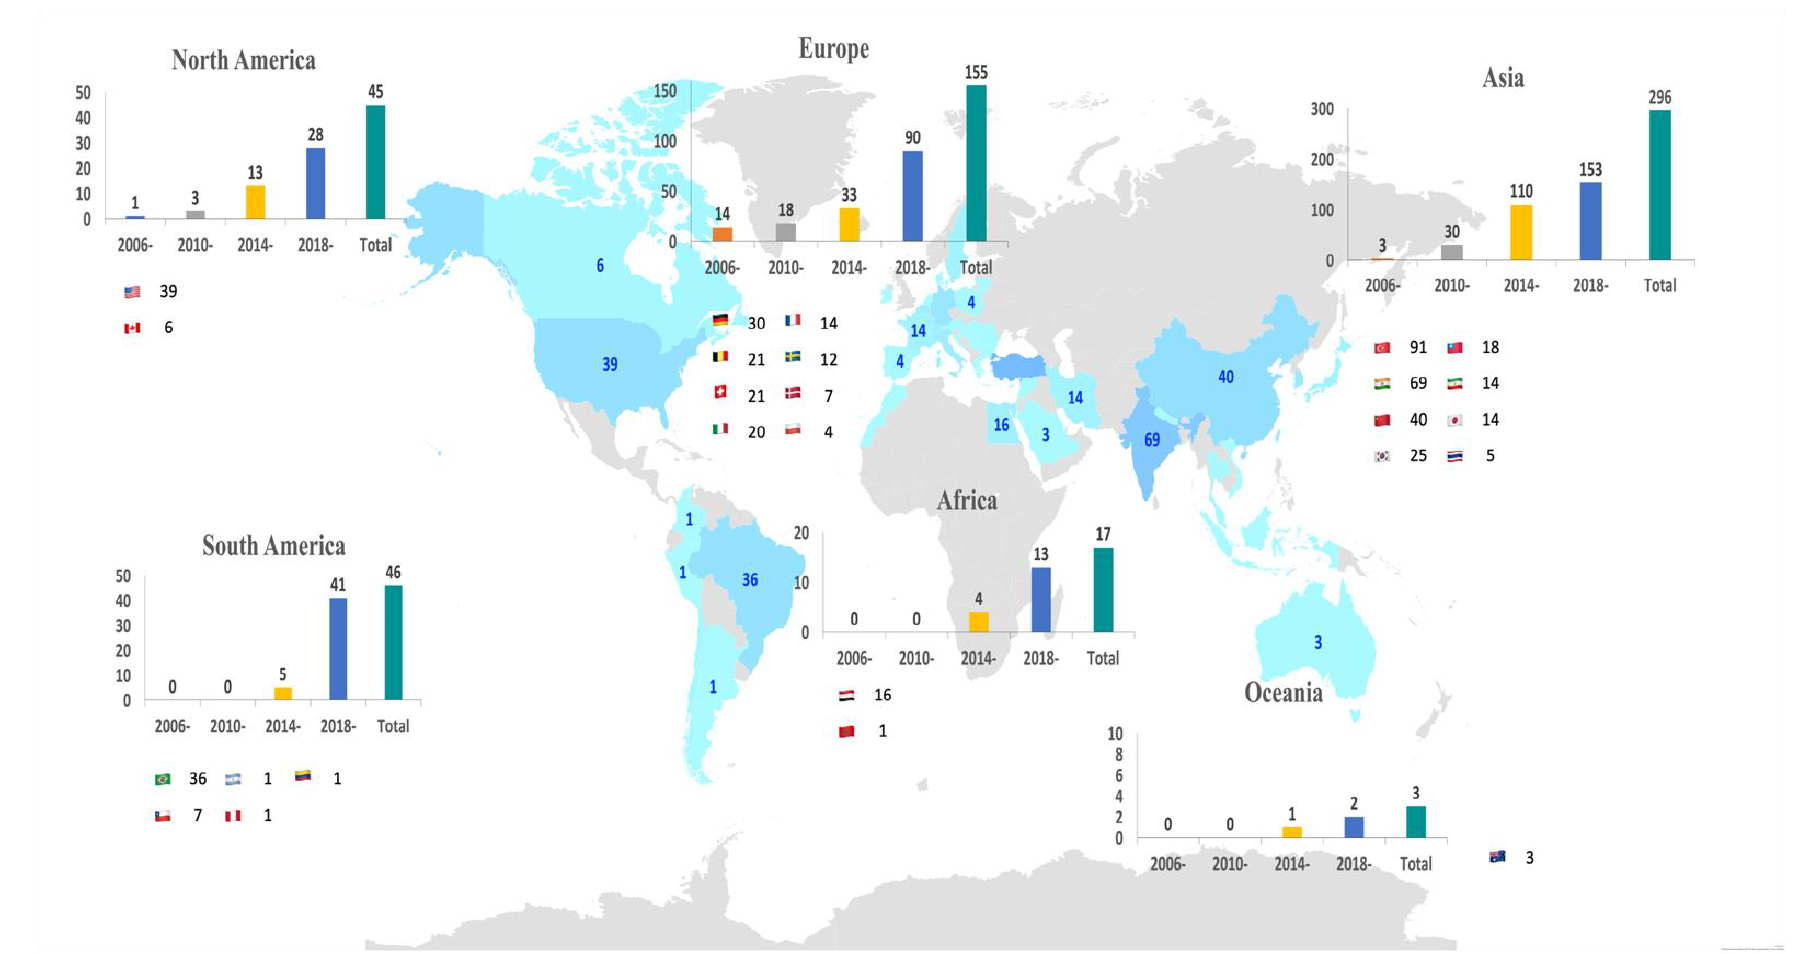
Figure 5. The current publications of PRF studies worldwide according to corresponding author. The blue color highlighted on the map represents the countries which have published PRF-related studies. The more the navy blue is the higher number of publication that the country has published.